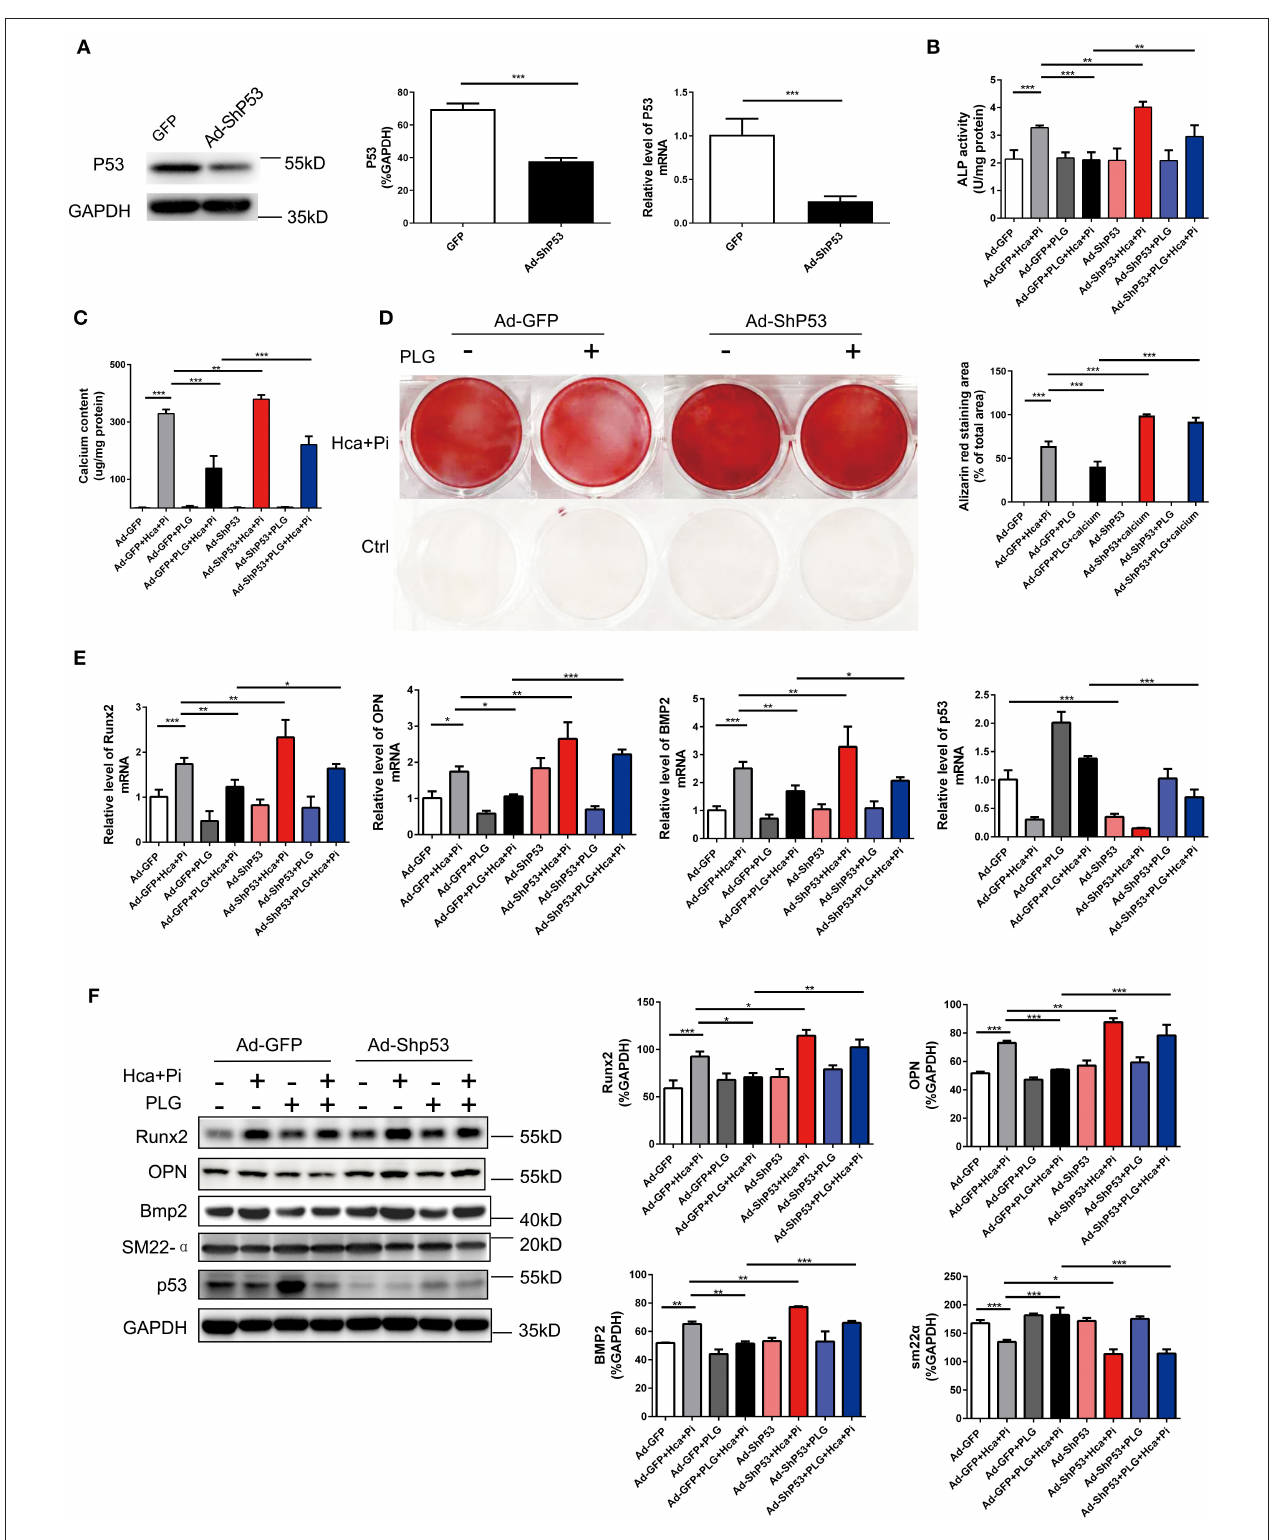
FIGURE 5 | PLG exerts anti-calcification functions by upregulating the P53 signaling pathway. (A) The efficacy of Ad-ShP53 for the knockdown of P53 was assessed by western blotting and qRT-PCR ( n = 6). The relative protein levels of P53 were normalized to the level of GAPDH. The data are shown as the mean ± standard